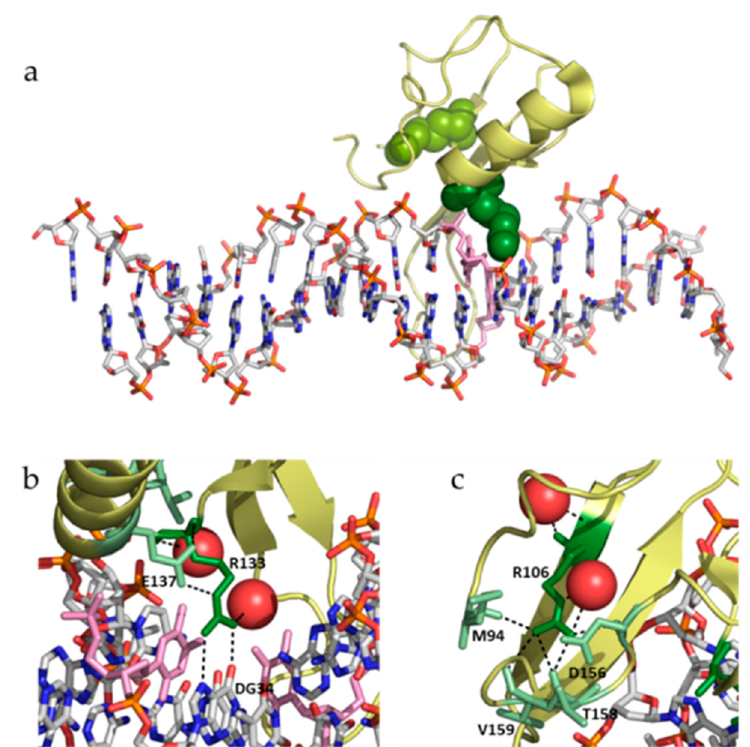
Figure 7. ( a ) Structure of MeCP2 MBD (yellow) in complex with methylated mCpG-dsDNA (CPK view) (pdb id: 3C2I). Residues R106 (light green spheres) and R133 (dark green spheres) are shown. Methylated cytosines are shown as pink sticks ( b ) Close view of R133 (dark green), showing the elements establishing hydrogen bonds with that residue: Glu137 (light green), deoxyguanosine-34 (CPK view), and two water molecules (red spheres). Methylated cytosines are shown in pink sticks. ( c ) Close view of R106 (dark green), showing the elements establishing hydrogen bonds with that residue: Met84, Asp156, T158, V159, and two water molecules (red spheres).